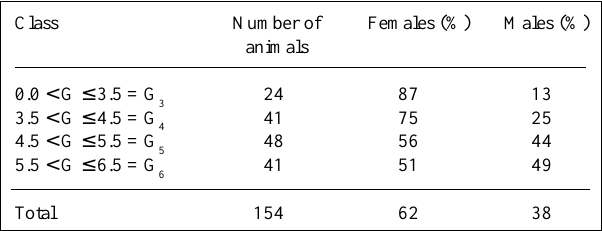
Table I - Distribution of the Canchim sample according to generation. Class Number of Females (%) Males (%)